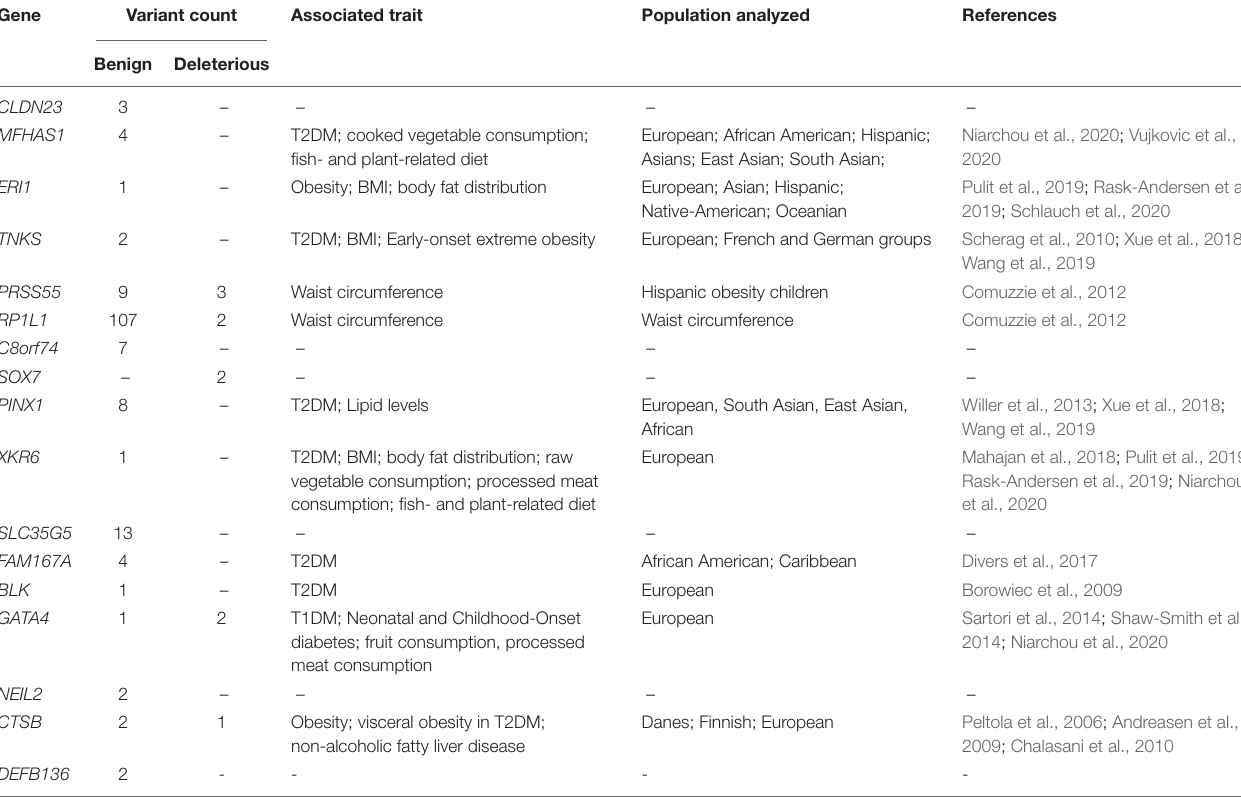
TABLE 2 | Genes associated with obesity-related traits that localize to the candidate region on ch 8p23.1 and are found to contain genetic variants in the Brazilian datasets analyzed in the present work. Gene Variant count Associated trait Population